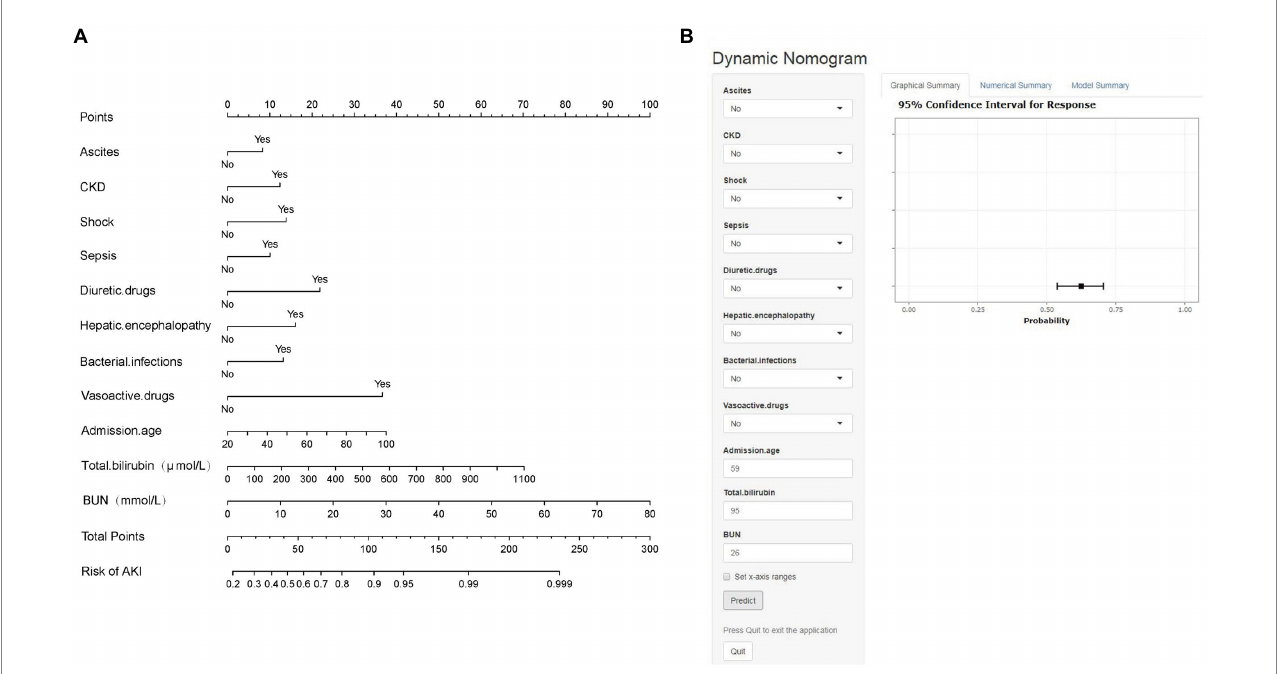
FIGURE 2 (A) Established nomogram for the prediction of AKI. (B) Online dynamic nomogram accessible at https://dynamicnomogram6666.shinyapps.io/ dynnomapp/. The measurement units for total bilirubin and BUN in the model are μ mol/L and mmol/L, and for total bilirubin, 1 mg/dL = 17.1umol/L, respectively.